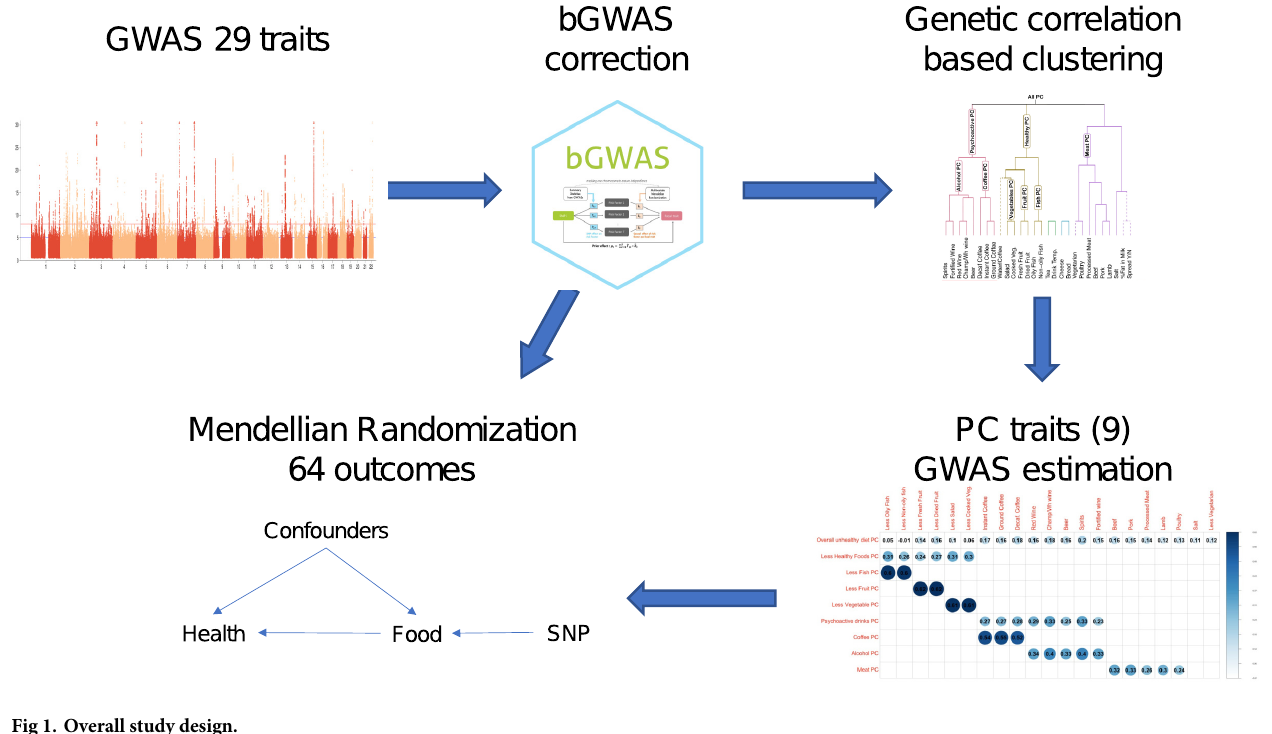
Fig 1. Overall study